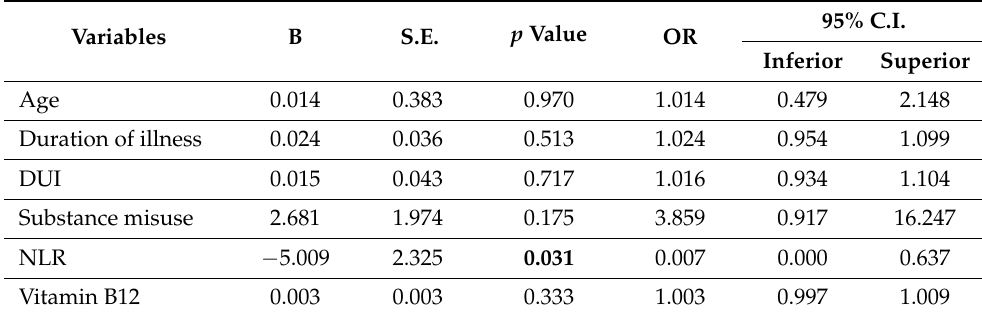
Table 2. Summary of the results from binary logistic regression